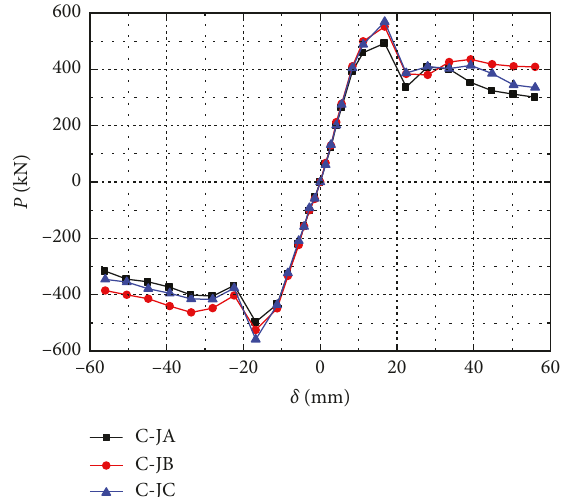
Figure 8: Skeleton curve of the specimens.